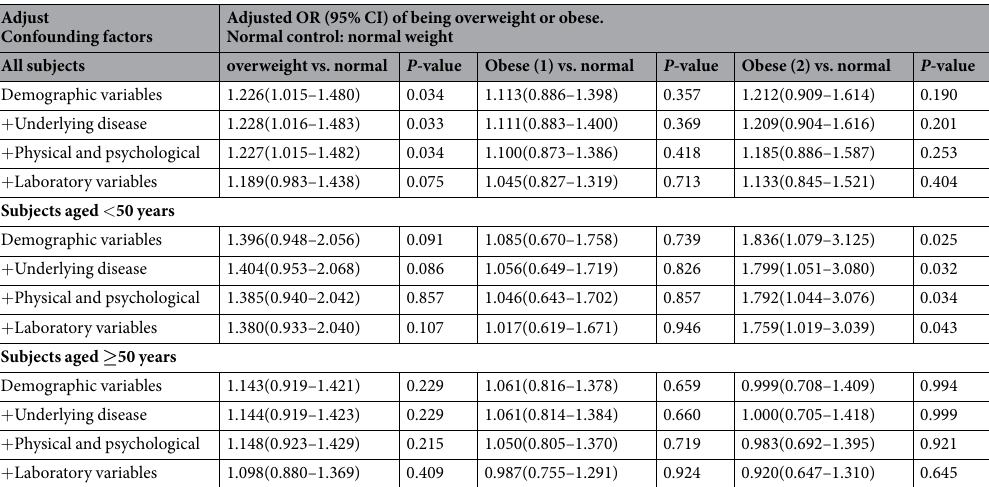
Table 3. The Odds ratio of being overweight or obese in subjects with H . pylori infection than normal control. The confounding factors were adjusted by a stepwise method: first demographic variable, second add underlying disease on demographic variable, third add physical and psychological score variable on demographic plus underlying diseases, finally including all confounding factors. OR = odds ratio, CI = 95% confidence interval. Demographic variables: age, sex, marriage. Underlying disease variables: DM. Physical and psychological score variables: MCS. Laboratory variables: WBC. Control group: normal weight BMI 18.5–24 kg/m 2